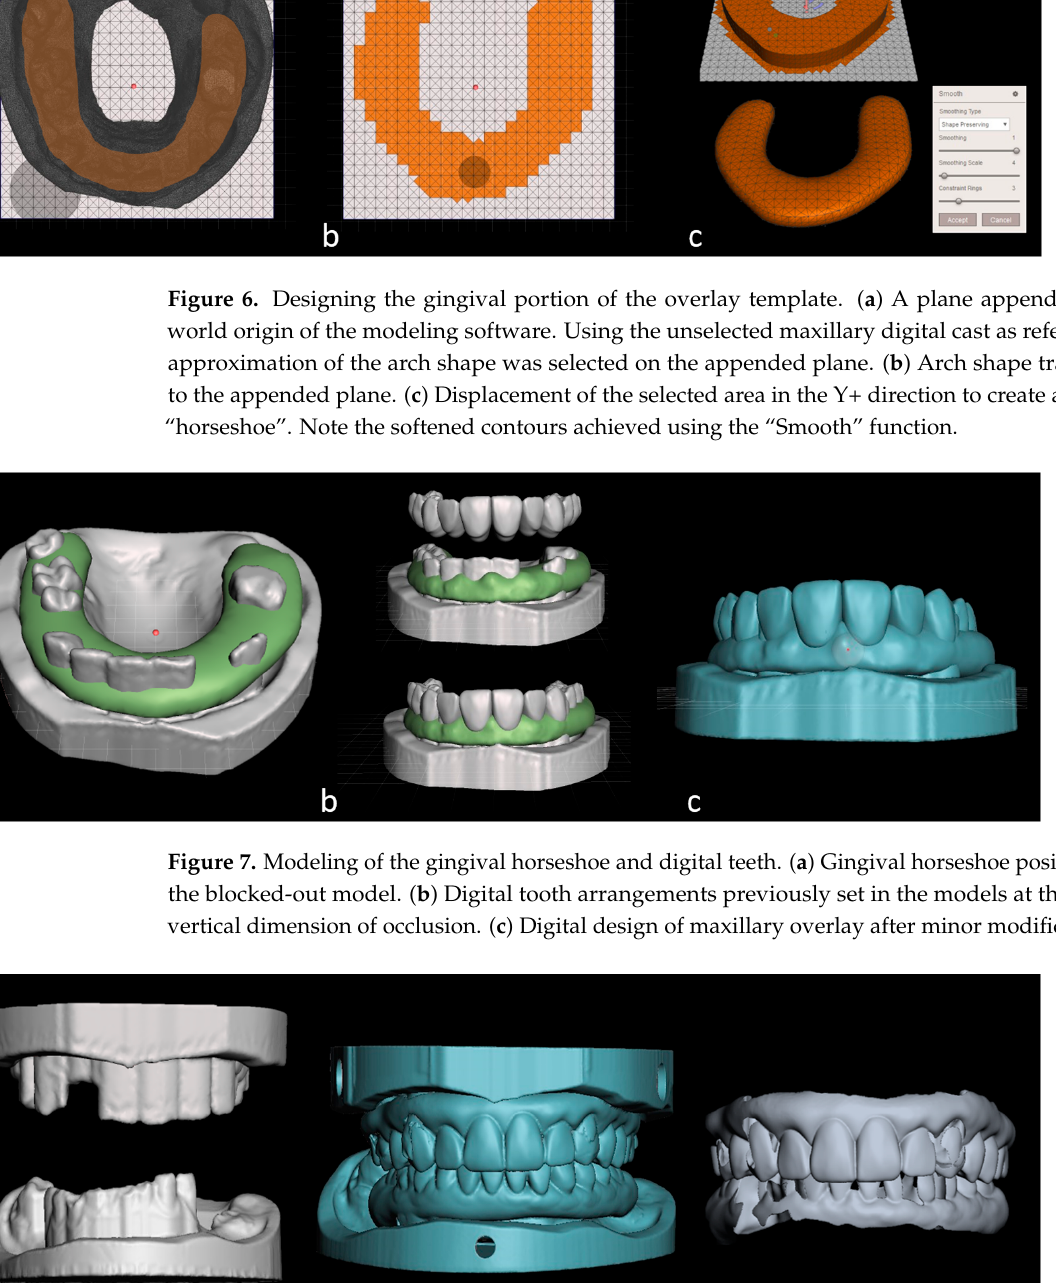
Figure 8. Finalized digital blocked-out casts and digital overlay templates. ( a ) Maxillary and mandibular blocked-out casts. ( b ) Maxillary and mandibular final overlay designs. ( c ) Overlay templates after subtraction of finalized blocked-out digital casts using the “Boolean difference” function.